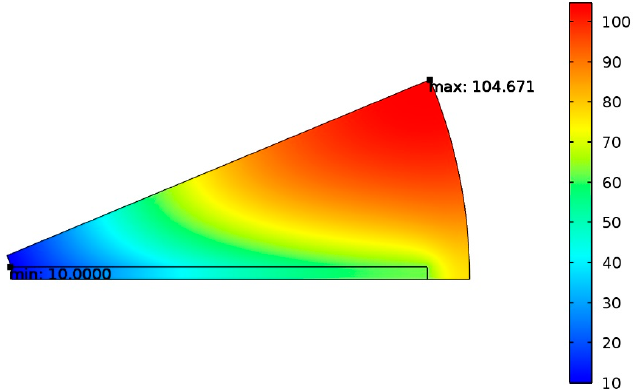
Figure 3. Temperature distribution of eight ‐ fin reactor at 60 s (temperature in °C).